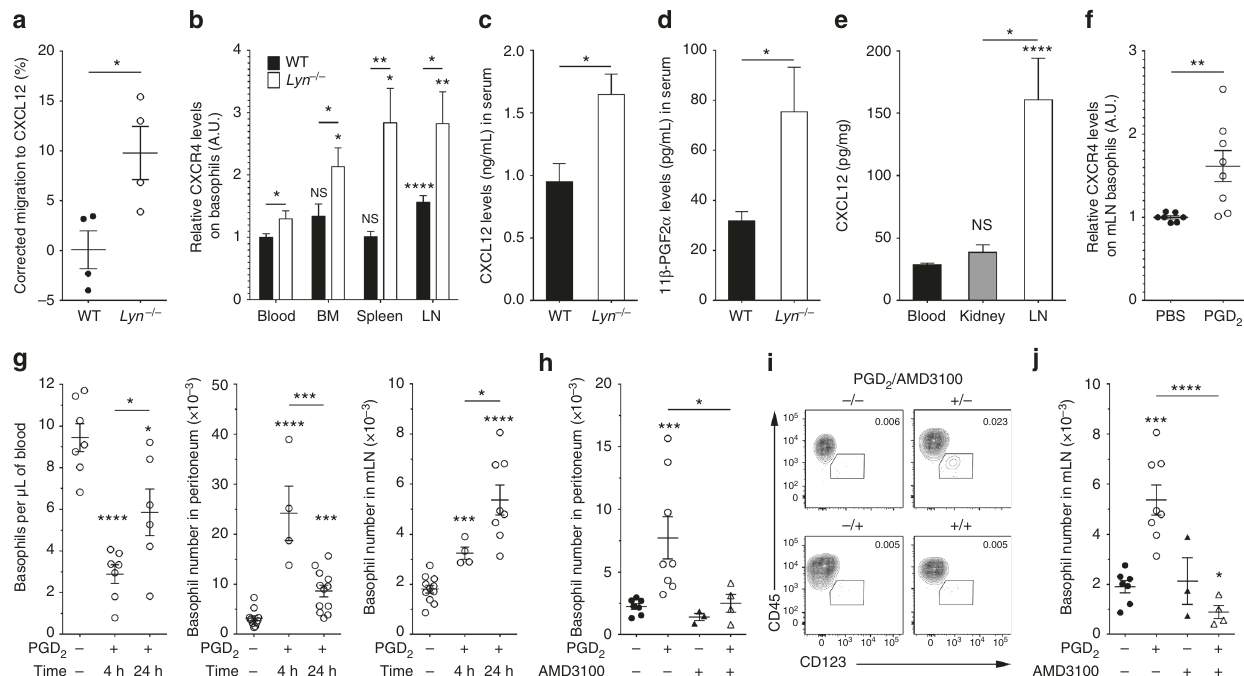
Fig. 4 PGD 2 induces CXCR4-dependent basophil homing to SLO in lupus-prone mice. a Ex vivo migration of basophils from whole splenocytes to CXCL12 from young WT ( n = 4) or Lyn – / – ( n = 4) mice. b CXCR4 expression on basophils in aged WT ( n = 16) and Lyn – / – ( n = 14) animals (BM: bone marrow,